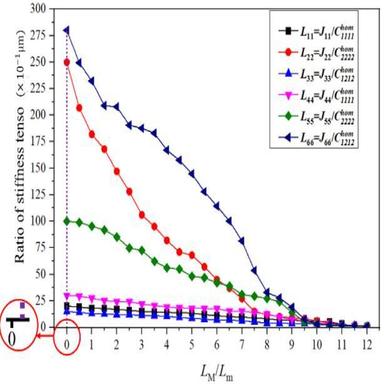
Constitutive constants for optimal RVE solids and L M /Lm.